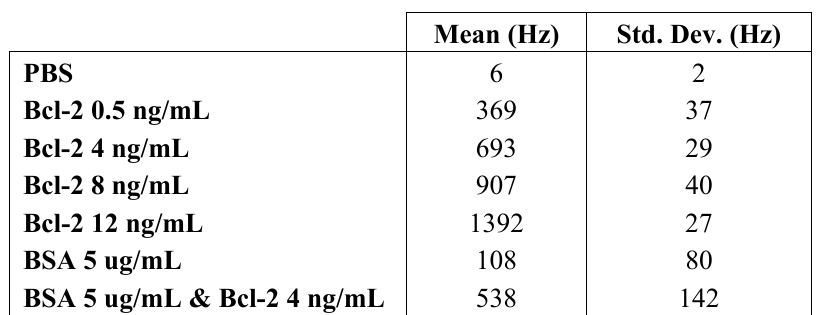
Table 1. Steady state frequency shifts of an acoustic biosensor for